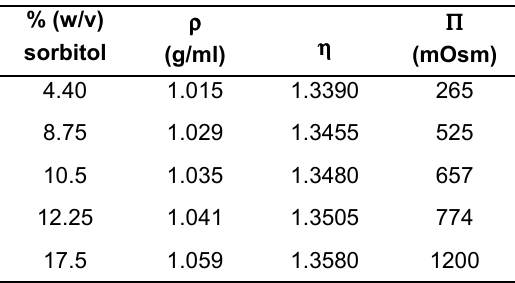
Density ( ρρρρ ), Refractive Index ( ηηηη ), and Osmolality ( ΠΠΠΠ ) of Sorbitol Solutions in